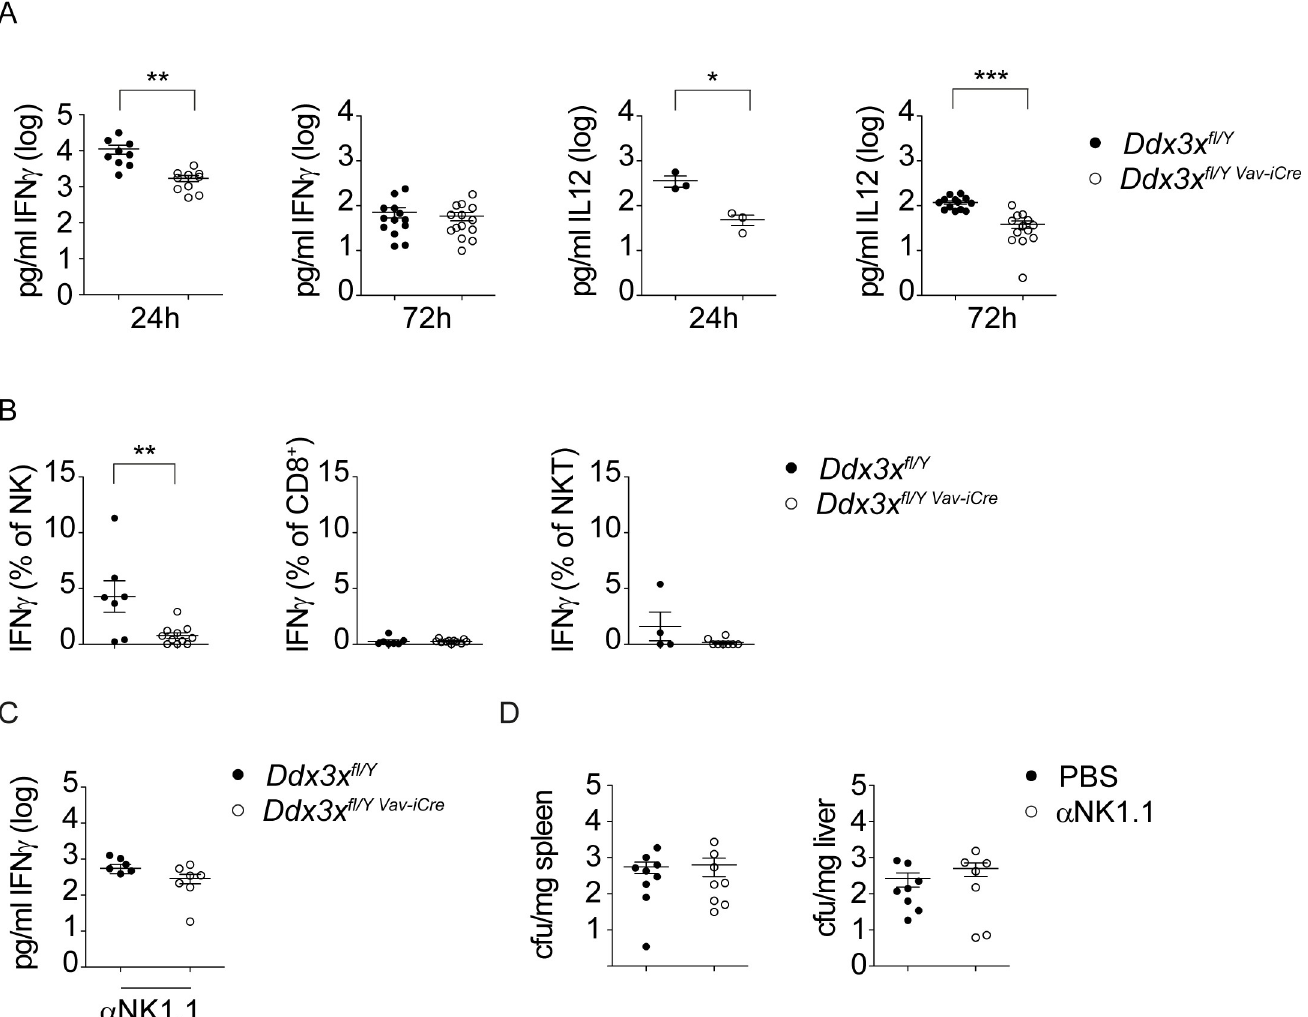
Fig 7. Reduced NK-mediated IFN γ production in Ddx3x fl/y Vav-iCre mice infected with Listeria monocytogenes . A Ddx3x fl/y and Ddx3x fl/y Vav-iCre mice were infected intraperitoneally with 1x10 5 CFU L . monocytogenes (strain EGD) for the indicated periods of time. n � 3 for each genotype. Mice were sacrificed and serum was collected. Cytokine levels were analyzed by flow cytometry-based bead array. B Ddx3x fl/y and Ddx3x fl/y Vav-iCre mice were infected intraperitoneally with 1x10 5 CFU L . monocytogenes (strain EGD) for 24 h, spleens were isolated, homogenized and splenocytes were stained for indicated surface markers followed by fixation, permeabilization and intracellular staining for IFN γ . Data show percent of IFN γ -producing CD3 ε - NK1.1 + NKp46 + (NK), CD3 ε + CD8 + (CD8 + ) and CD3 ε + CD1d-tet + (iNKT) cells. n = 7 for Ddx3x fl/y and n = 11 for Ddx3x fl/y Vav-iCre mice, analyzed in 3 independent experiments. C After depleting NK-cells with an anti-NK1.1